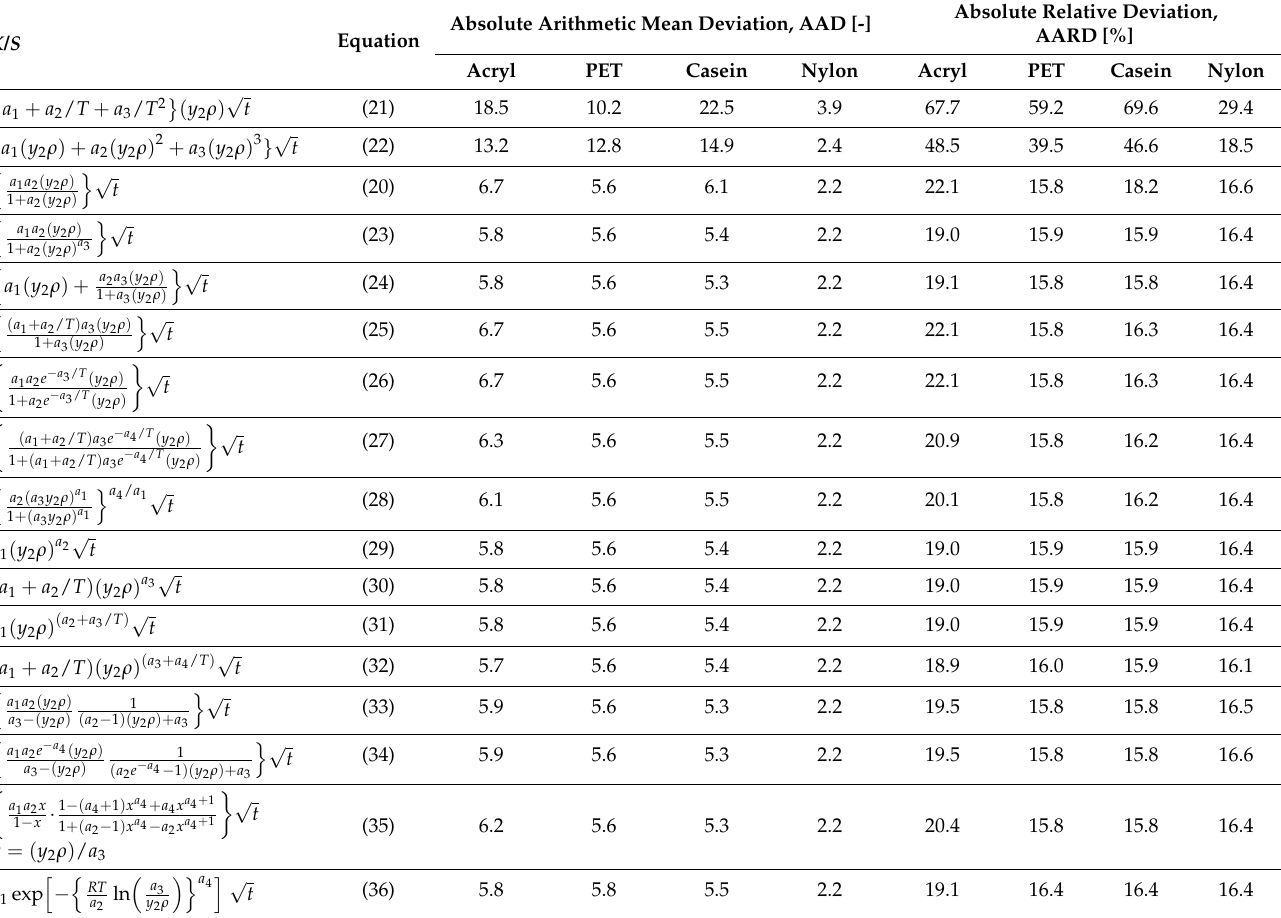
Table 5. Absolute arithmetic mean deviation and relative mean deviation for K / S between experi- mental and calculated values obtained by Equations (20) to